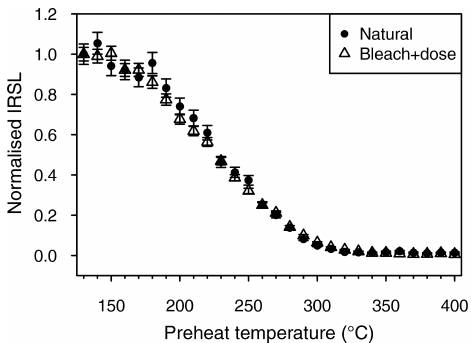
Figure 4. To determine thermal quenching, repeated short shine measurements of L x /T x for a given dose of 90Gy after preheats at different temperatures were conducted on one aliquot of RIN2 F.